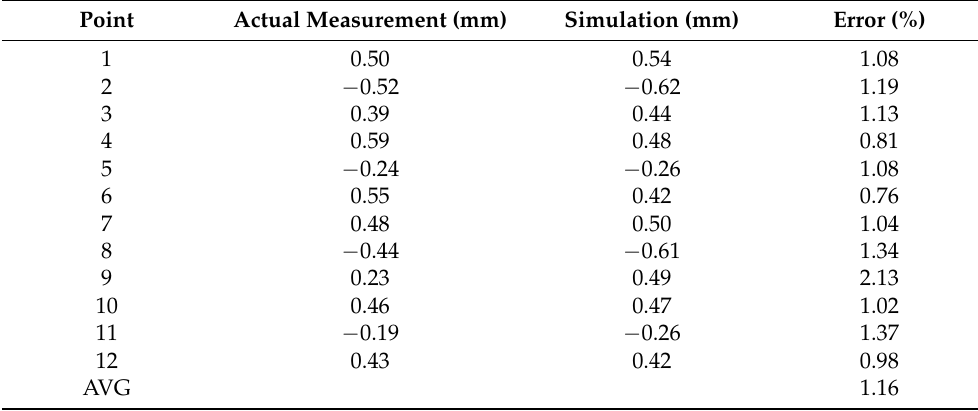
Table 3. Comparison of Actual and Simulation Measurements of Z -axis Warpage Deformation.